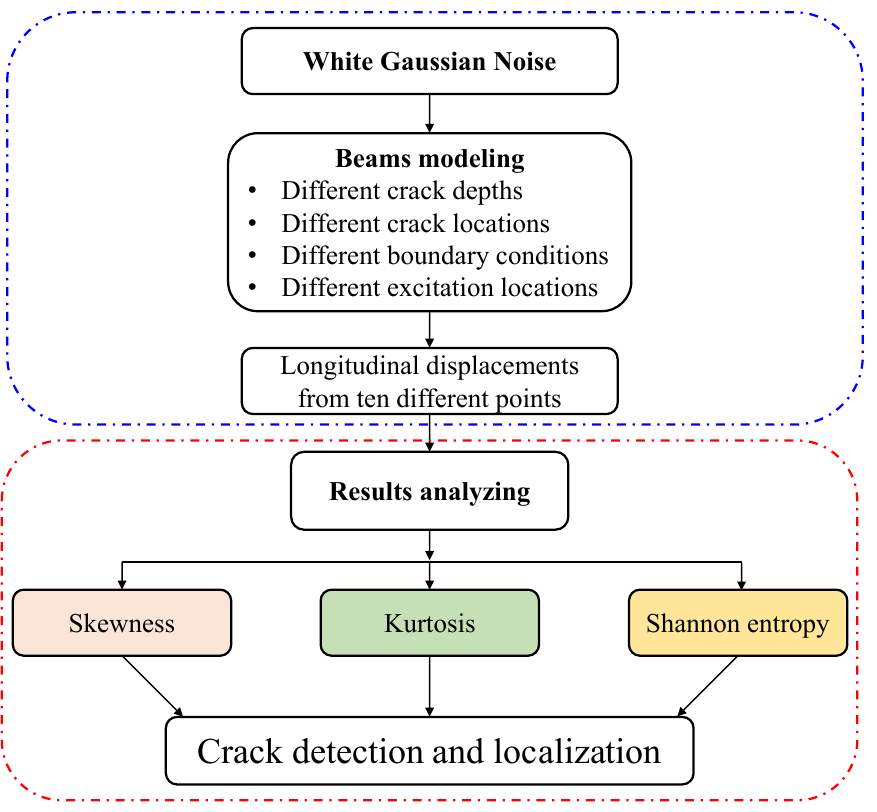
Figure 1. Flowchart of the methodology used for breathing crack detection and